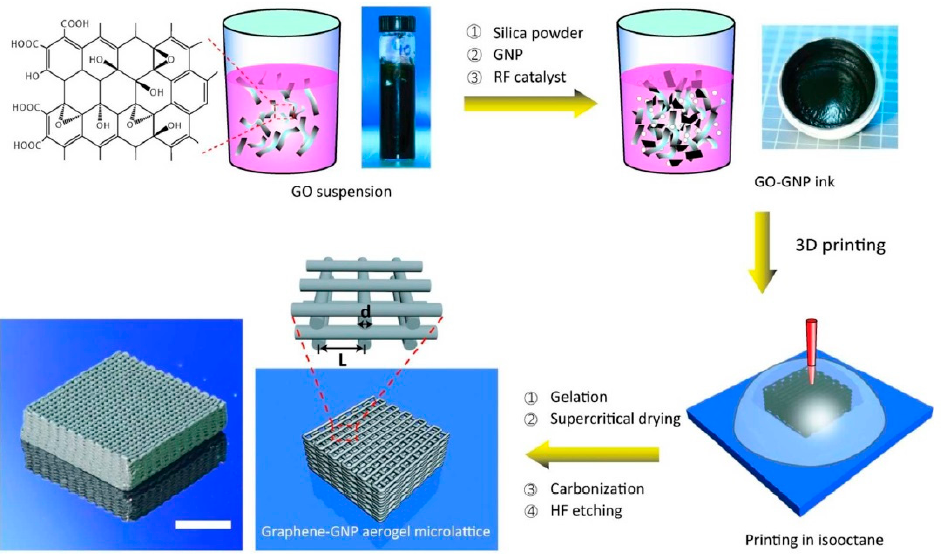
Figure 20. Schematic diagram part fabrication process: Mixing of SiO 2 , GNPs and R-F with the aqueous GO suspension. Then, the as-prepared GO paste was extruded in an isooctane bath, and the as-obtained part was gelled at 85 ◦ C, then dried using supercritical carbon dioxide. Finally, the silica fillers were etched using diluted hydrofluoric acid. The scale bar is 10 mm. Reprinted Reproduced from [213], with permission from American Chemical Society, 2016.